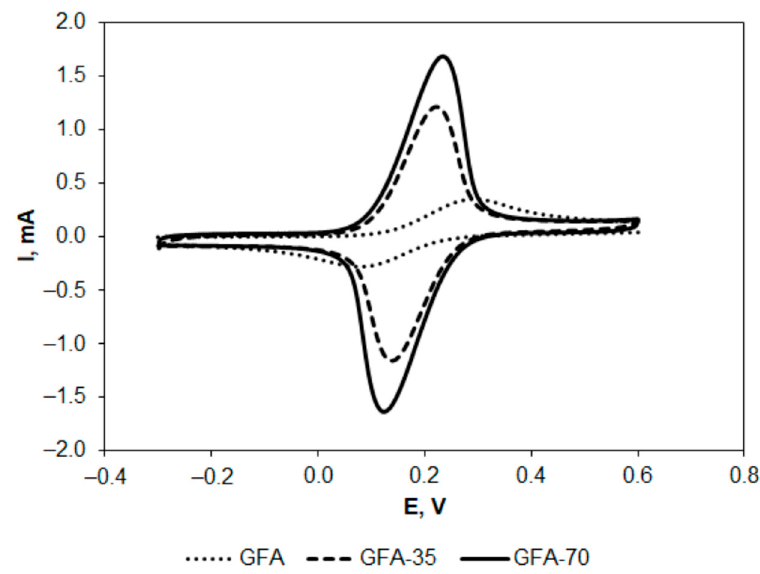
Figure 3. Cyclic voltammograms recorded at GFA electrodes in K 4 [Fe(CN) 6 ] (5 × 10 − 3 mol L − 1 in 0.1 mol L − 1 KCl) at the scan rate of 5 mV s − 1 .